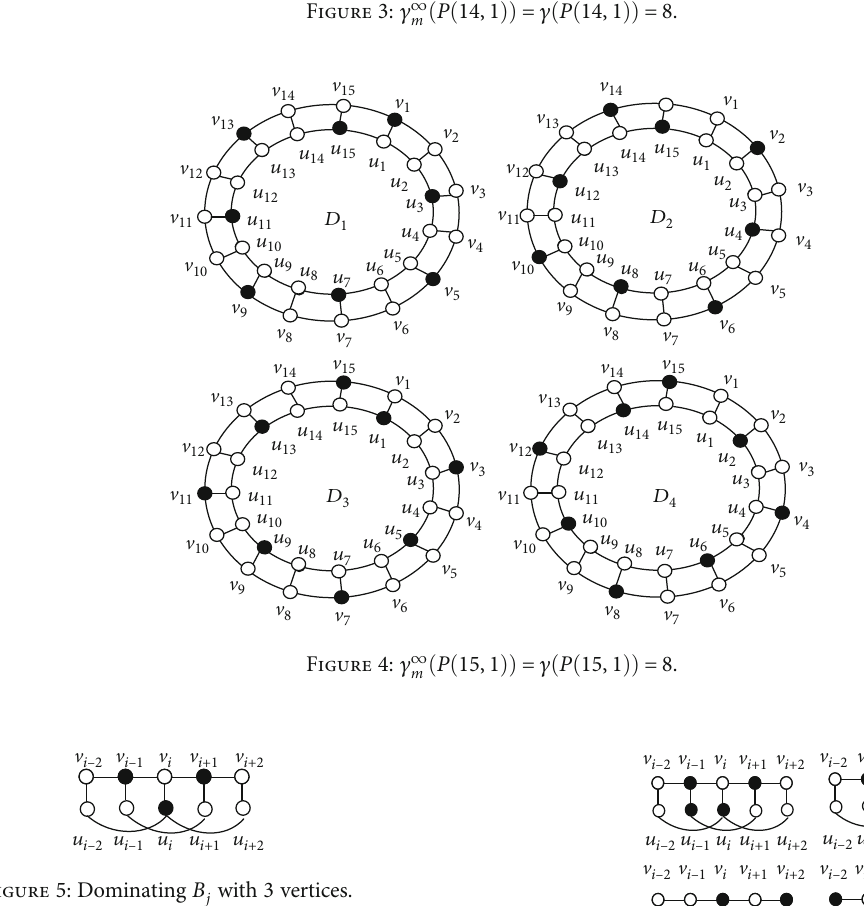
j with 3 vertices.